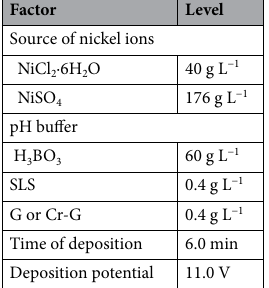
Table 1. Bath components and working environments for electrodeposition of Ni@G@MA and Ni@Cr-G@ MA coating on the steel